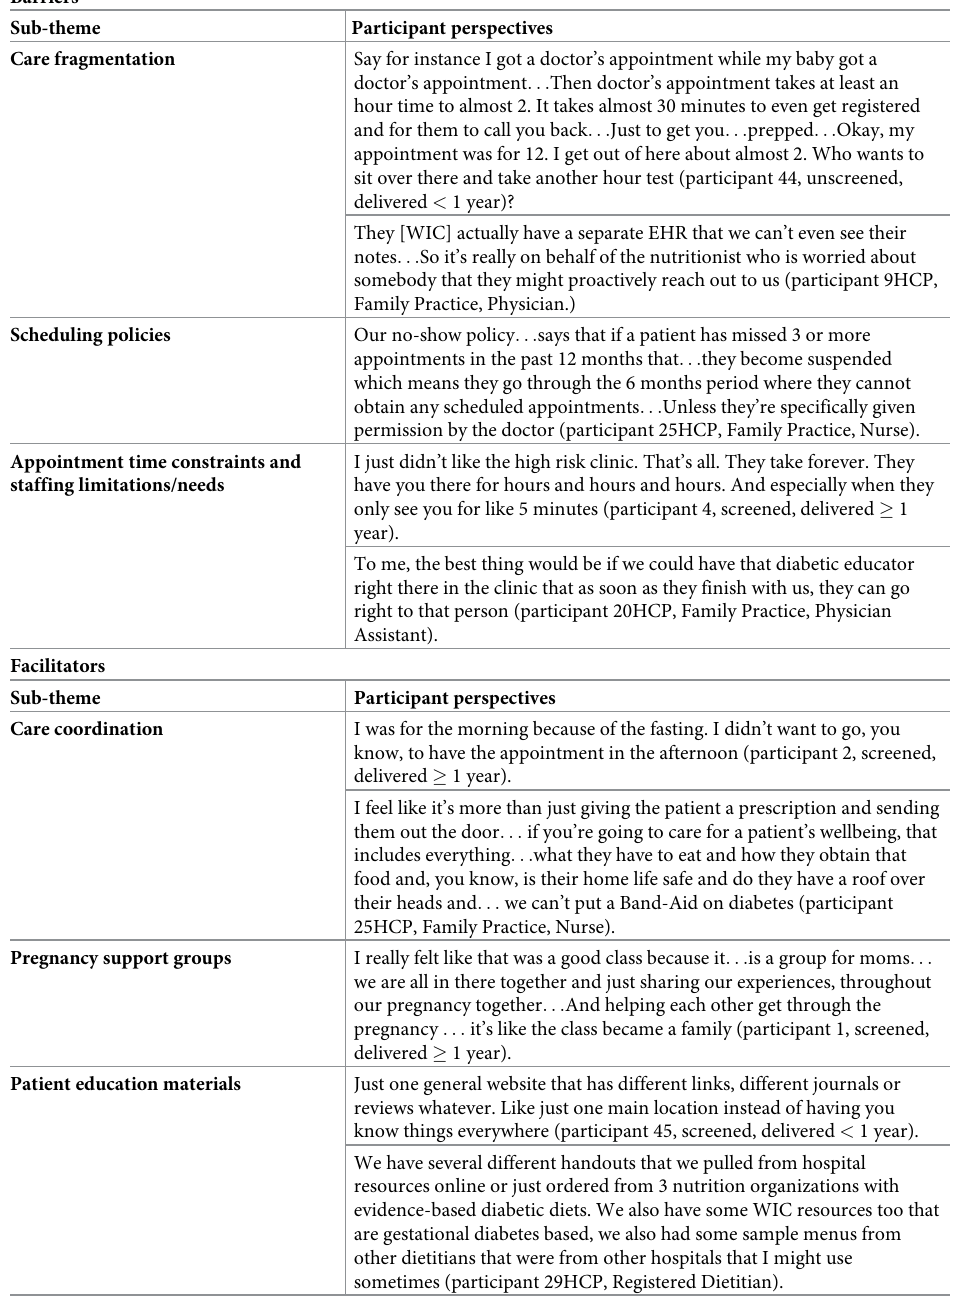
Table 3. Healthcare system level barriers and facilitators to postpartum diabetes screening and prevention: Exem- plar